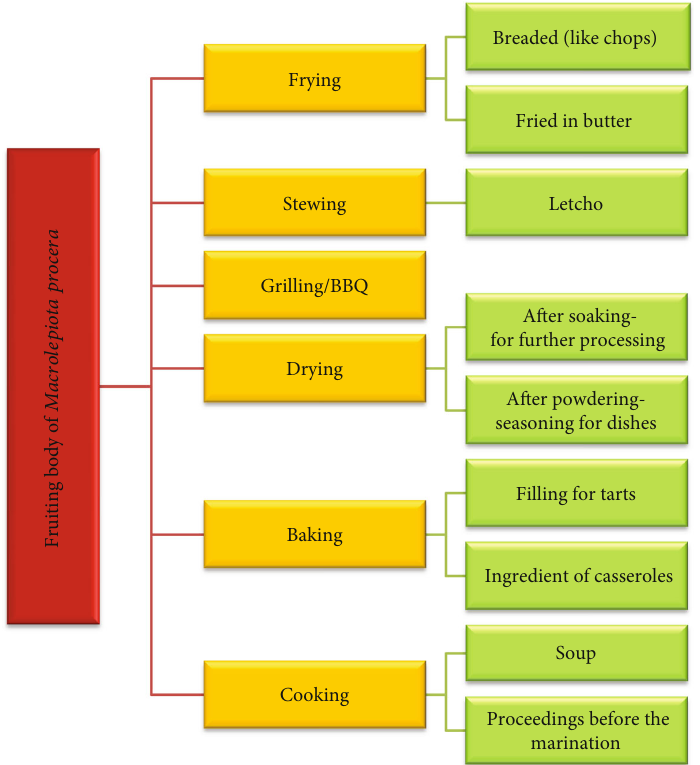
Figure 4: The use of the Macrolepiota procera fruiting bodies for